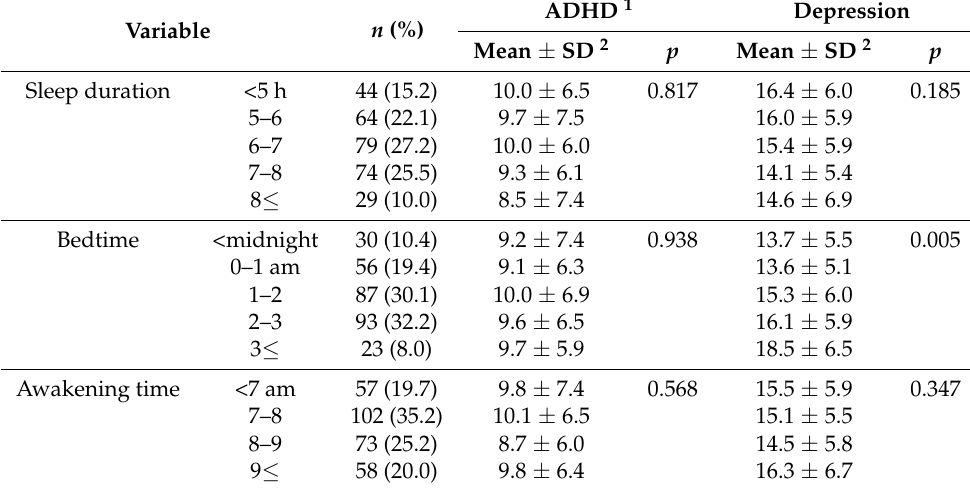
Table 2. Comparison of ADHD and depression scores among subgroups of sleep patterns. ( n = 290). Variable